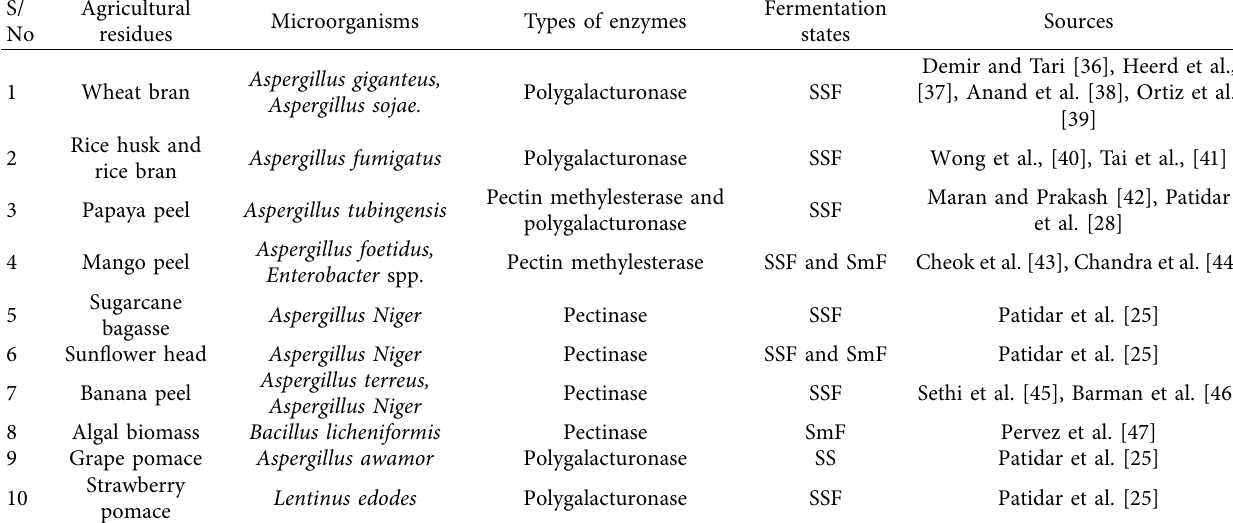
Table 3: Agro-industrial waste as substrates for pectinase production by using